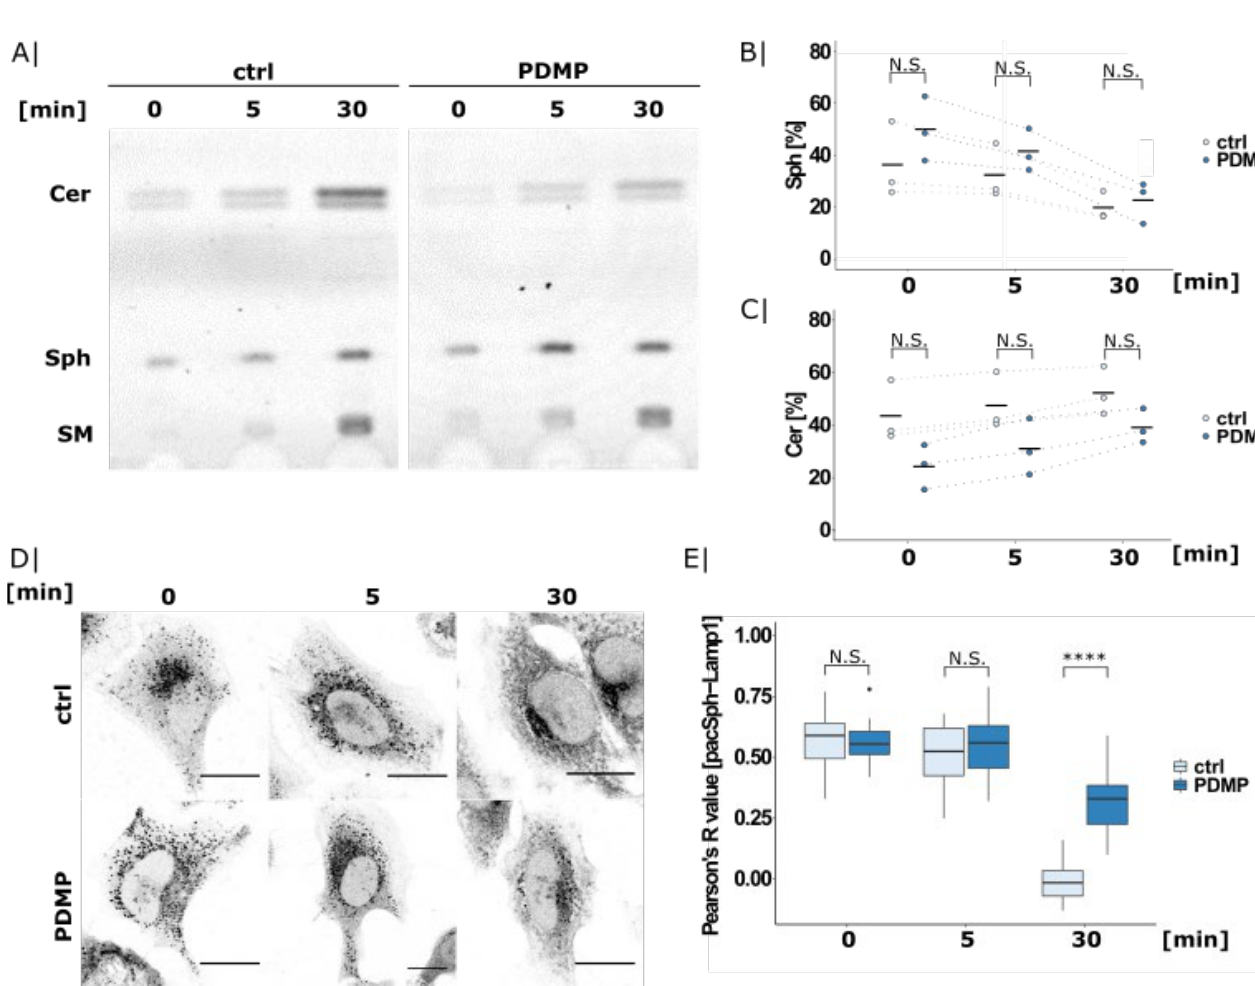
Figure 2. pacSph export from lysosomes studied by short pulse-chase experiments. ( A ) TLC analysis of pacSph metabolism in SGPL1 − / − cells. Cells were treated with PDMP overnight (20 µ M) and labelled with 2 µ M pacSph for 5 min. After chasing in lipid-free medium for 0, 5, or 30 min, the cells were harvested, and the lipids were extracted and clicked to a fluorogenic coumarin-azide. Sphingolipid species were separated by TLC. Quantification of ( B ) sphingosine and ( C ) ceramide levels. The fluorescent signal corresponding to the sphingosine or ceramide band from the TLC experiment shown in Figure 2A was divided by the total intensity of all of the fluorescently labelled lipids. This was extracted from three independent experiments and is presented as a dot plot, including the calculated mean. Welch two sample t -tests were performed between the control and PDMP (0 min: N.S. p = 2.9 × 10 − 1 ; 5 min: N.S. p = 3.1 × 10 − 1 ; and 30 min: N.S. p = 6.4 × 10 − 1 ). ( D ) Confocal microscopy images of PDMP-treated and pacSph-labelled cells as described above. Lipids were cross-linked and clicked to a fluorophore upon fixation. Lysosomes were visualized using Lamp1 antibody staining (Figure S3). Scale bar indicates 20 µ m. ( E ) Pearson’s correlation coefficient of pacSph and Lamp1 was extracted for each condition (0 min ctrl: n = 25 cells; 5 min ctrl: n = 12 cells; 30 min ctrl: n = 20 cells; 0 min PDMP: n = 24 cells; 5 min PDMP: n = 18 cells; and 30 min PDMP: n = 23 cells) and illustrated as boxplots. Center lines show median; box limits indicate first (Q1) and third quartiles (Q3); and whiskers extend to a maximum distance of 1.5*IQR (interquartile range) from Q1 and Q3, respectively, or to the most extreme data point within that range. Welch two sample t -tests were performed between control and PDMP (0 min: N.S. p = 7.7 × 10 − 1 ; 5 min: N.S. p = 5.5 × 10 − 1 ; and 30 min: **** p = 1.3 × 10 − 11